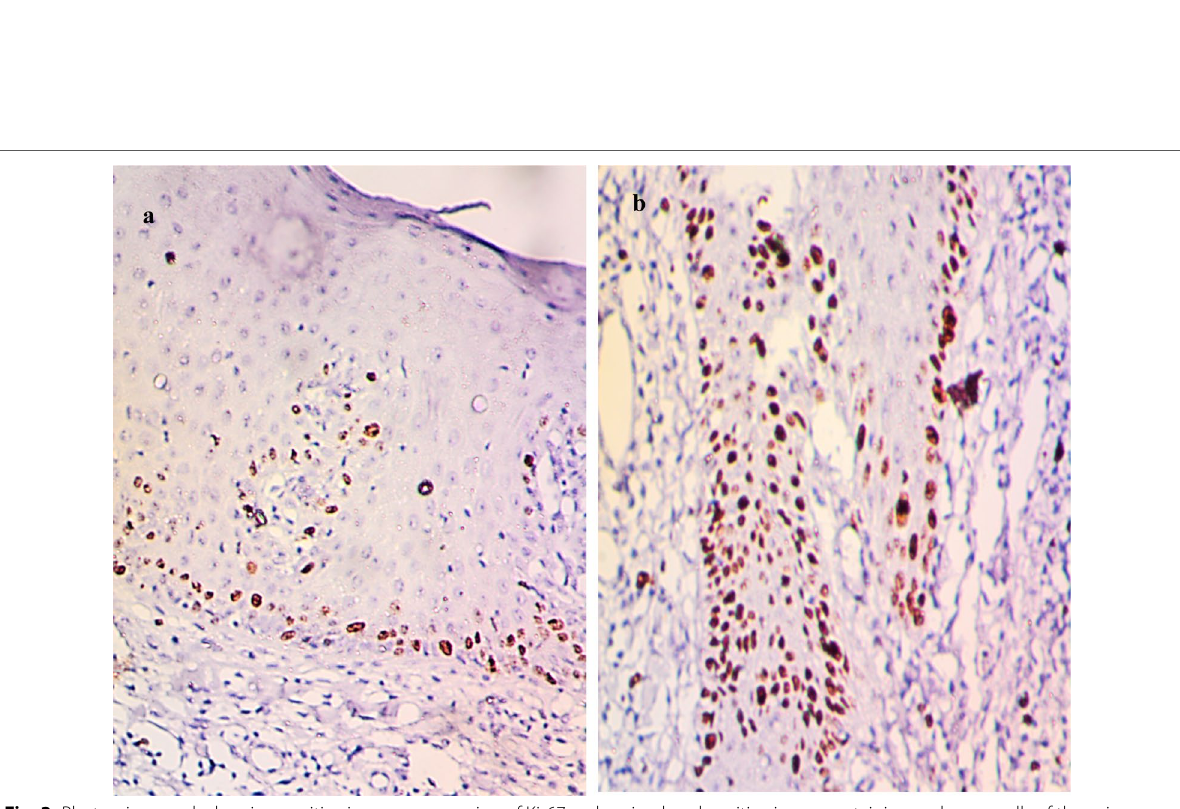
Fig. 3 Photomicrograph showing positive immunoexpression of Ki-67, a showing basal positive immune staining and some cells of the spinous cell layer, b showing basal and parabasal intense immunostaining ( ×